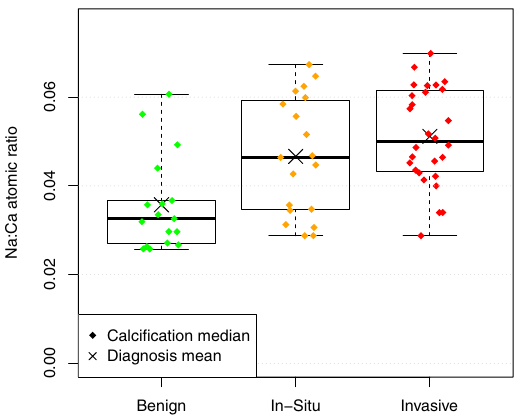
Figure 6. The Na:Ca ratio of calcifications in specimens with a benign diagnosis is significantly lower than that in specimens categorised as malignant (In-Situ or